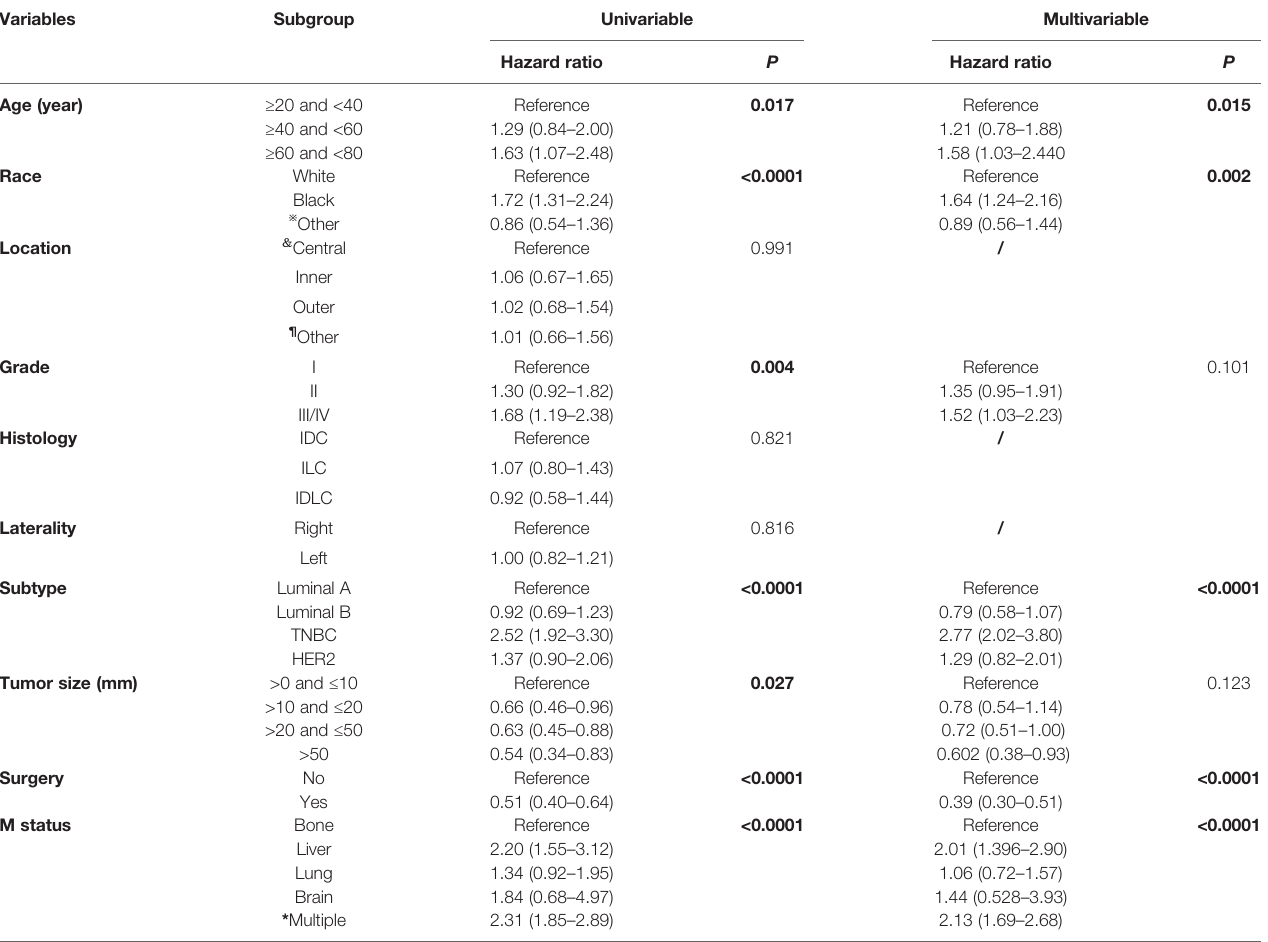
TABLE 3 | Univariate and multivariate Cox regression analyses of predictive variables correlated with CSS in IV stage female breast cancer with negative-lymph node